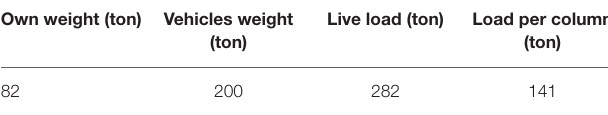
TABLE 1 | Calculation of axial load on the critical